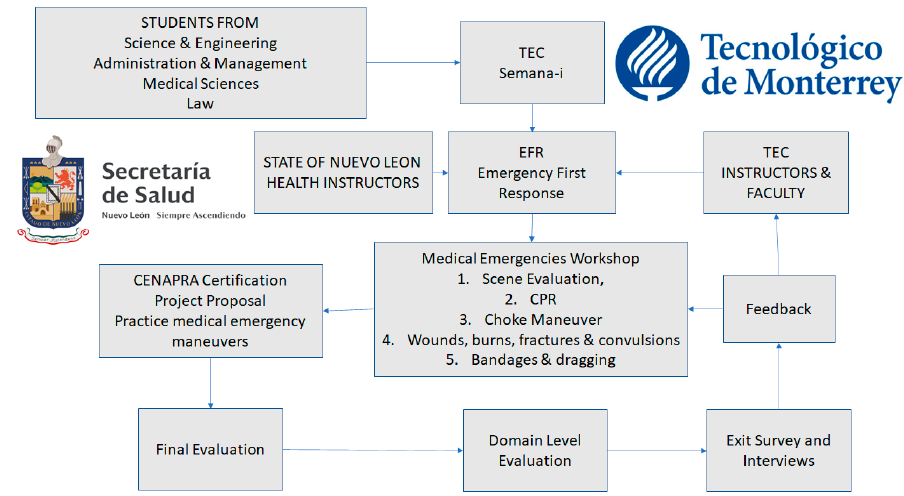
Figure A6. Process interactions in the EFR study for college students at TEC, Secretaría de Salud (Nuevo León State, México) and the “emergency first response” competency evaluation of the student population.